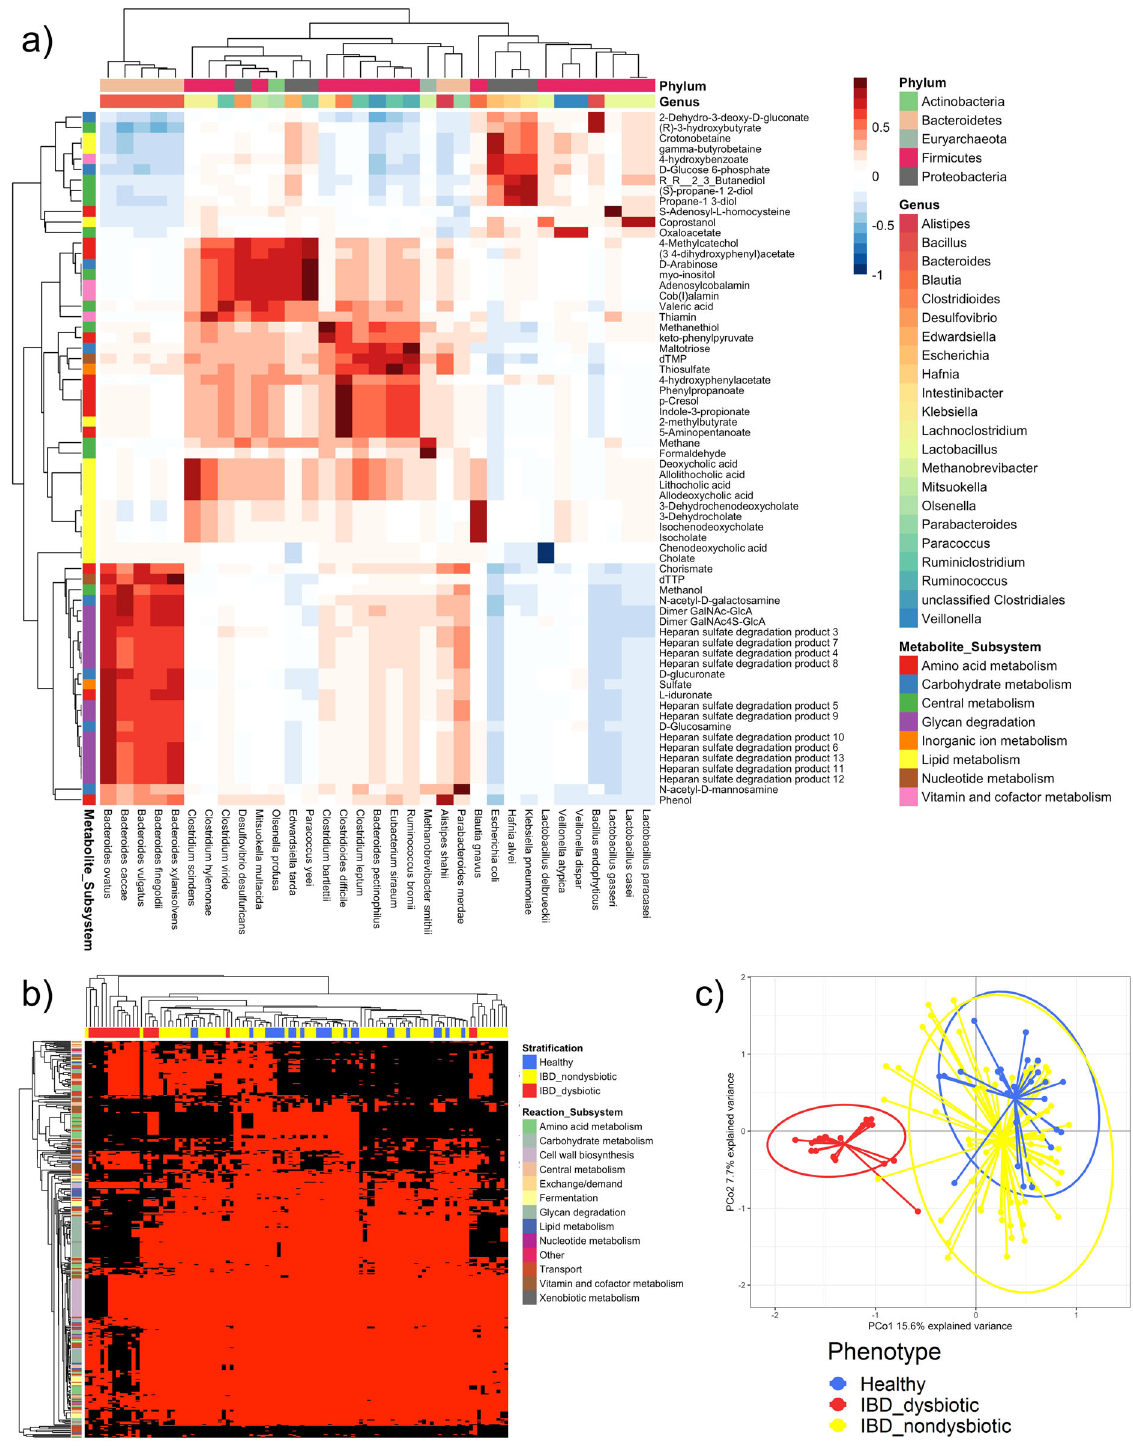
Fig. 3 Metabolic properties and fl ux pro fi les computed for the 108 microbiomes. a Spearman correlations between metabolite secretion fl uxes (mmol/person/day) and species-level relative abundances across all 108 microbiome models. Shown are only the 66 metabolites for which the positive or negative correlation with at least one species was higher than 0.75 or lower than − 0.75, respectively. Rows show metabolites annotated by subsystem, and columns show species annotated by genus and phylum. b Absolute reaction presence in the 108 microbiome models than differed signi fi cantly ( p -value corrected for false discovery rate < 0.05, Supplementary Table 4b) between the 20 dysbiotic and 63 dysbiotic IBD microbiomes. Rows show reactions annotated by subsystem, and columns show microbiome models annotated by group. Red = reaction present, black = reaction absent. c Principal coordinates analysis of all 26,873 strain to metabolite contributions (mmol/person/day, Supplementary Table 6) computed for the 108 microbiome models.